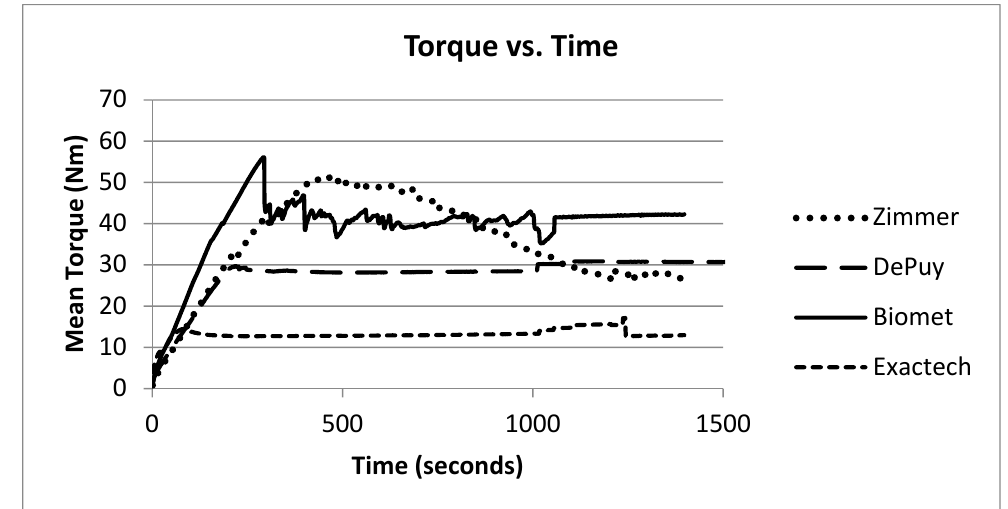
Figure 2. Mean torque vs. time for each implant. The mean displacement was on average greatest for the Zimmer implants. The two Exactech implants were inconsistent, as were the two Biomet implants (Table 5). Mean displacement was inversely correlated with the torsional stiffness (Figures 3 and 4). Table 5. Mean displacement, torsional stiffness, and load for each implant.